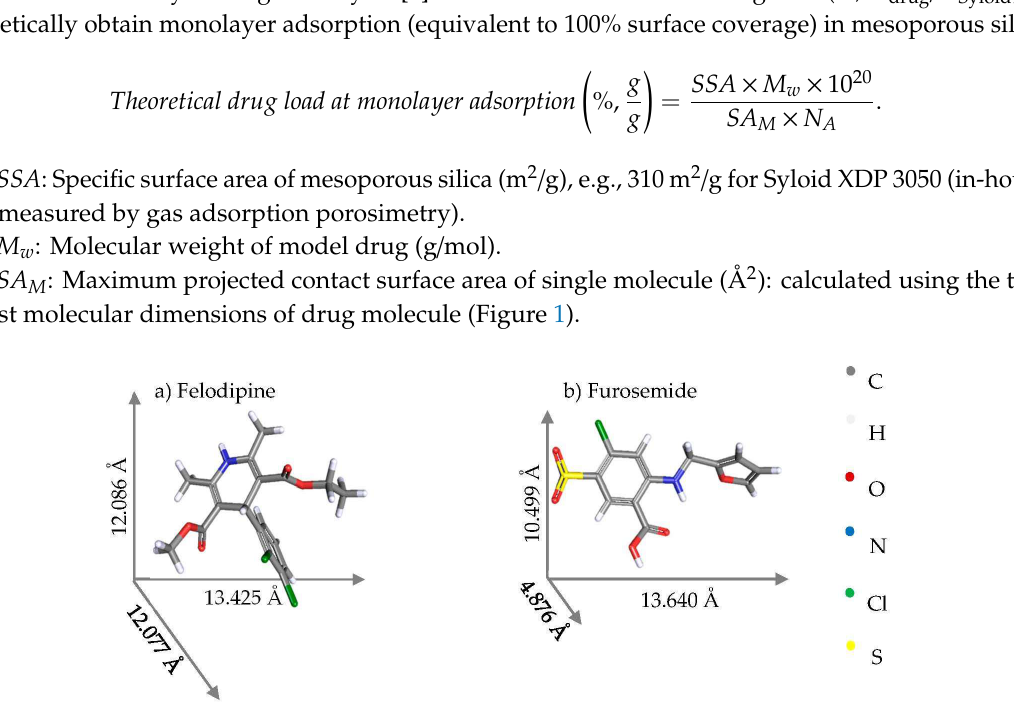
Figure 1. Molecular structures [13,14] and estimated molecular dimensions of Felodipine and Furosemide generated from the Cambridge Crystallographic Data Centre.